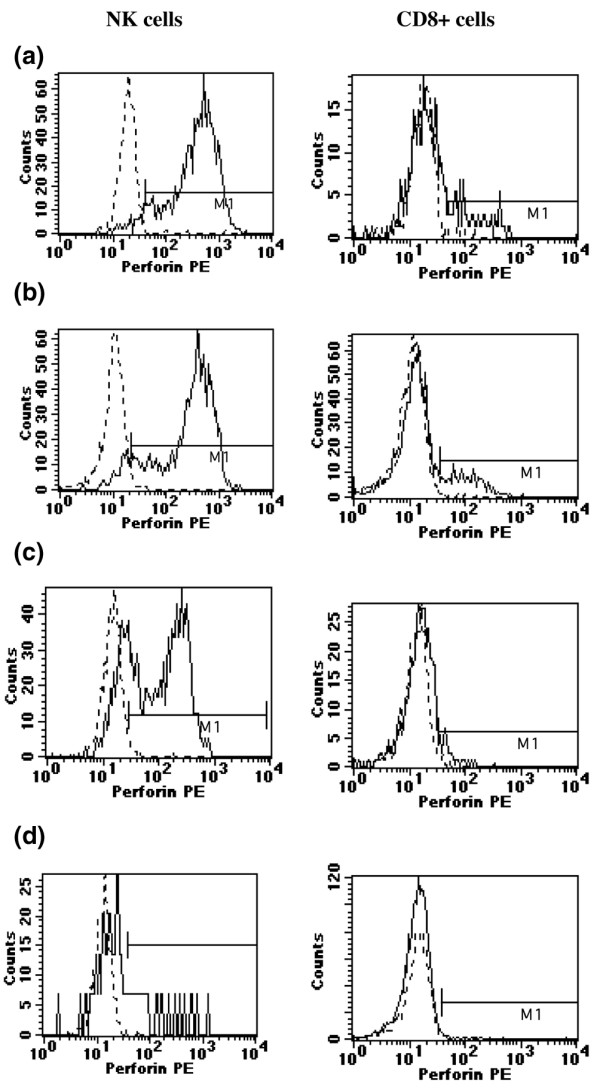
Flow cytometric analysis of perforin expression in NK cells and cytotoxic CD8+ cells. (a) Normal control: 95% of NK cells and 14% of CD8+ cells are perforin-positive. (b) A patient with systemic juvenile rheumatoid arthritis (sJRA) with a normal pattern of perforin expression: normal mean channel fluorescence (MCF) in NK cells with 92% of NK cells and 10% of CD8+ T cells being perforin-positive (this pattern was observed in all controls, in 18 of 20 other JRA patients, and in 15 of 20 sJRA patients). (c) A patient with sJRA with low MCF in NK cells and mildly decreased proportions of perforin-positive NK cells (74%) and CD8+ T lymphocytes (5%) (this pattern was observed in 2 of 20 other JRA patients and in 5 of 20 sJRA patients). (d) A patient with sJRA with low MCF in NK cells and very low proportions of perforin-positive NK cells (20%) and no perforin-positive CD8+ T lymphocytes (observed in 1 of 20 sJRA patients only).